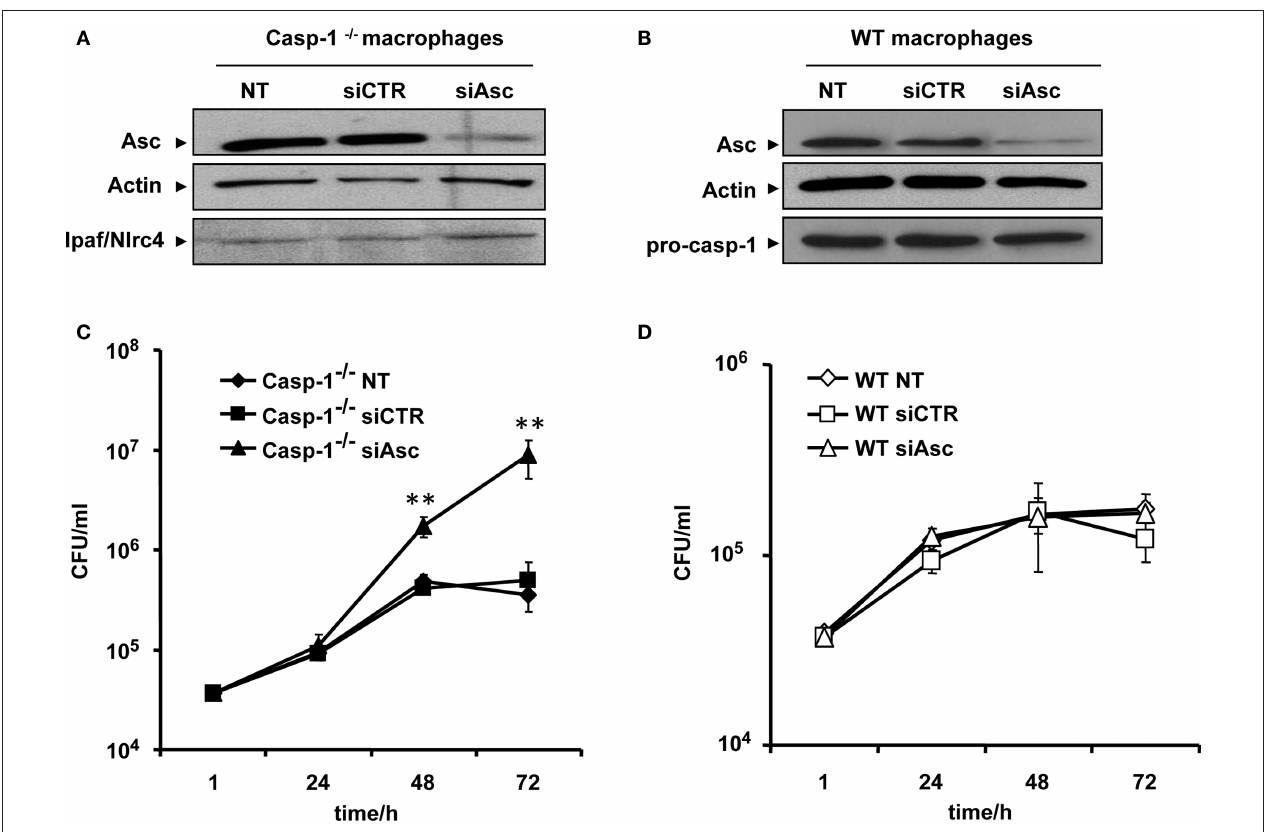
transfected or not (NT) with siAsc or siCTR and 48 h after transfection cells were infected with L. pneumophila (Leg) at MOI = 0.1 and the bacterial replication was assessed by counting the CFU after 1, 24, 48, and 72 h. Results are displayed as mean ± SD of three independent wells. ** P ≤ 0.01. The data shown in (C,D) are representative of four independent experiments showing the same